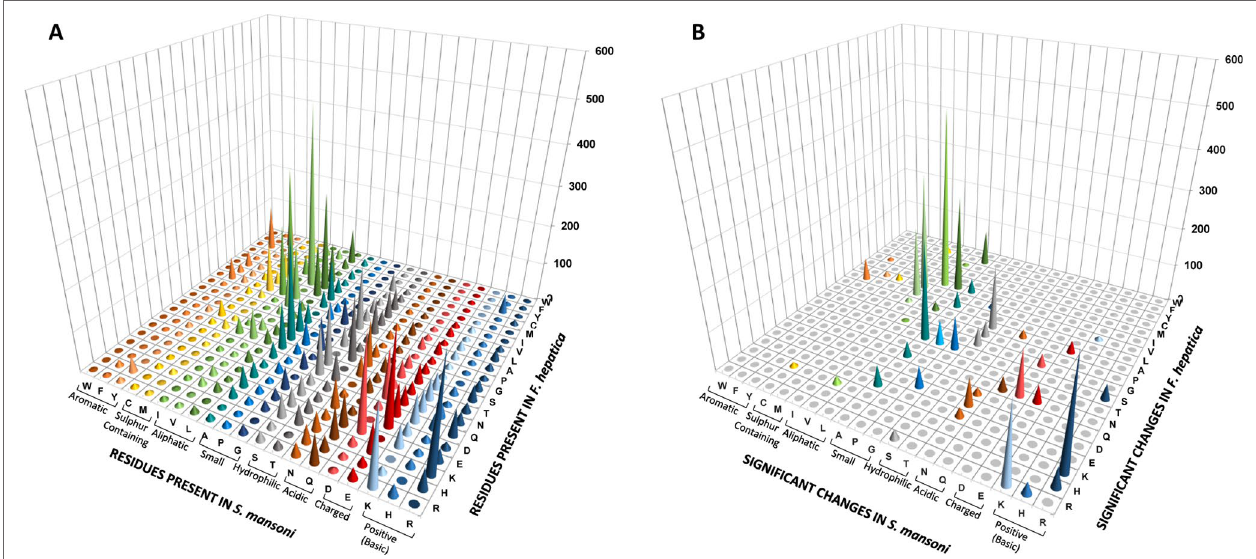
FIGURE 7 | Non-synonymous amino acid changes between F. hepatica and S. mansoni . (A) Graphical representation of a substitution matrix of amino acids present at orthologous positions in alignments. The residues are indicated. Amino acids present on S. mansoni are ordered and color coded by property. (B) Non- synonymous reciprocal changes that show significant